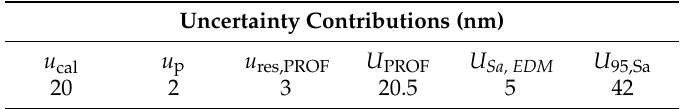
Table 1. The uncertainty contributions for the Sa roughness measurements on the scanning